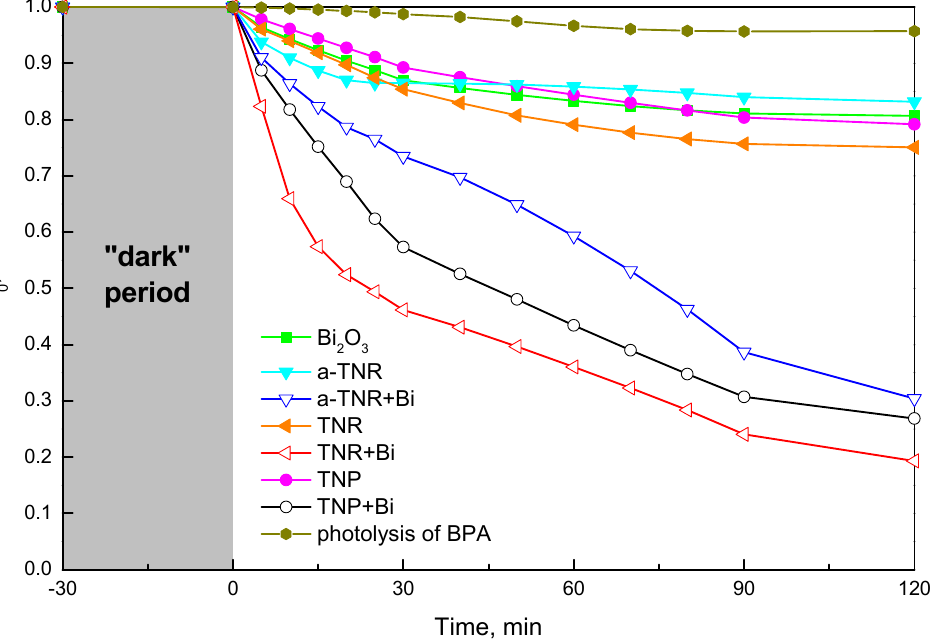
Figure 7. Photocatalytic degradation of bisphenol A (BPA) (c 0 = 10 mg / L) in the presence of prepared materials (c cat. = 125 mg / L) under visible-light irradiation.